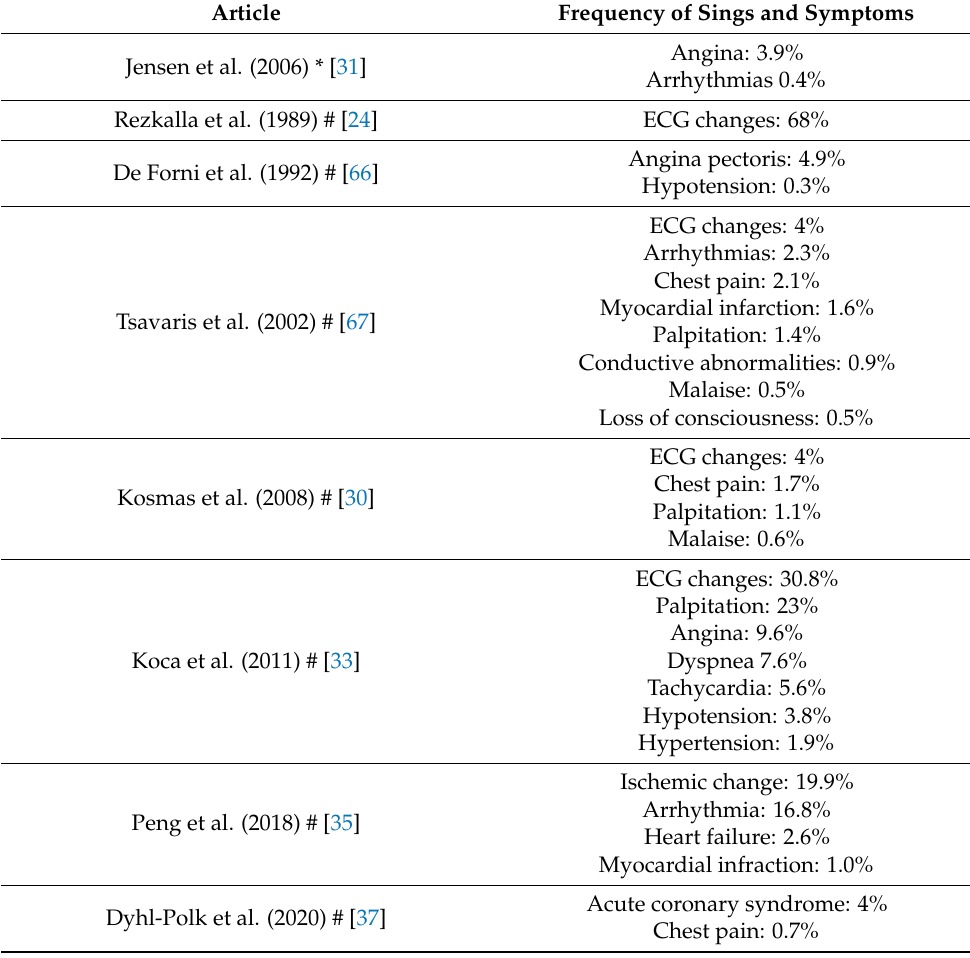
Table 2. Frequency of signs and symptoms after the administration of 5-FU. *—retrospective study; #—prospective